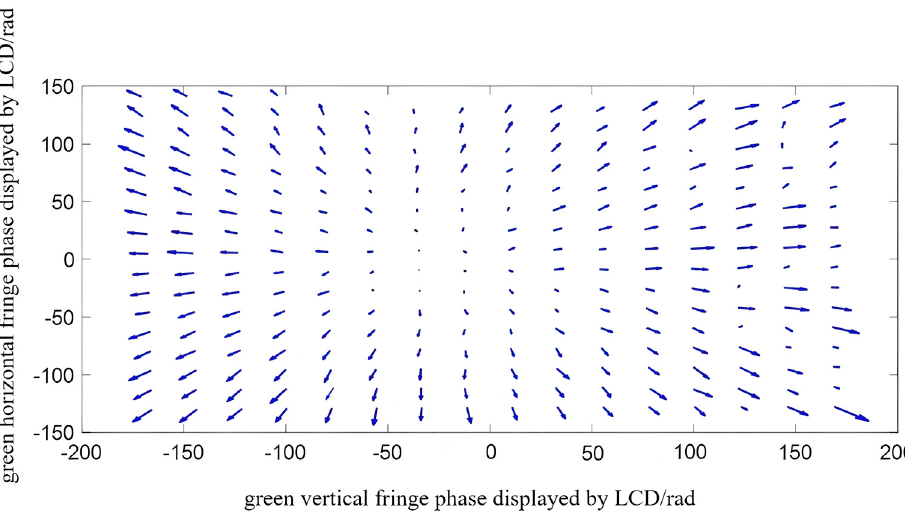
According to step 4, a pre − compensated fringe image is generated by using the